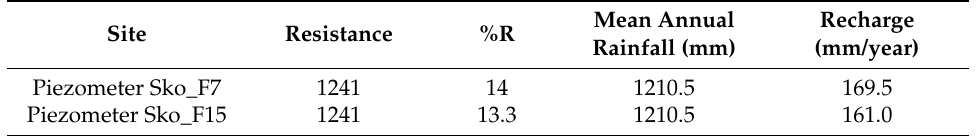
Table 1. The values used to calibrate the model (%R: Percentage of